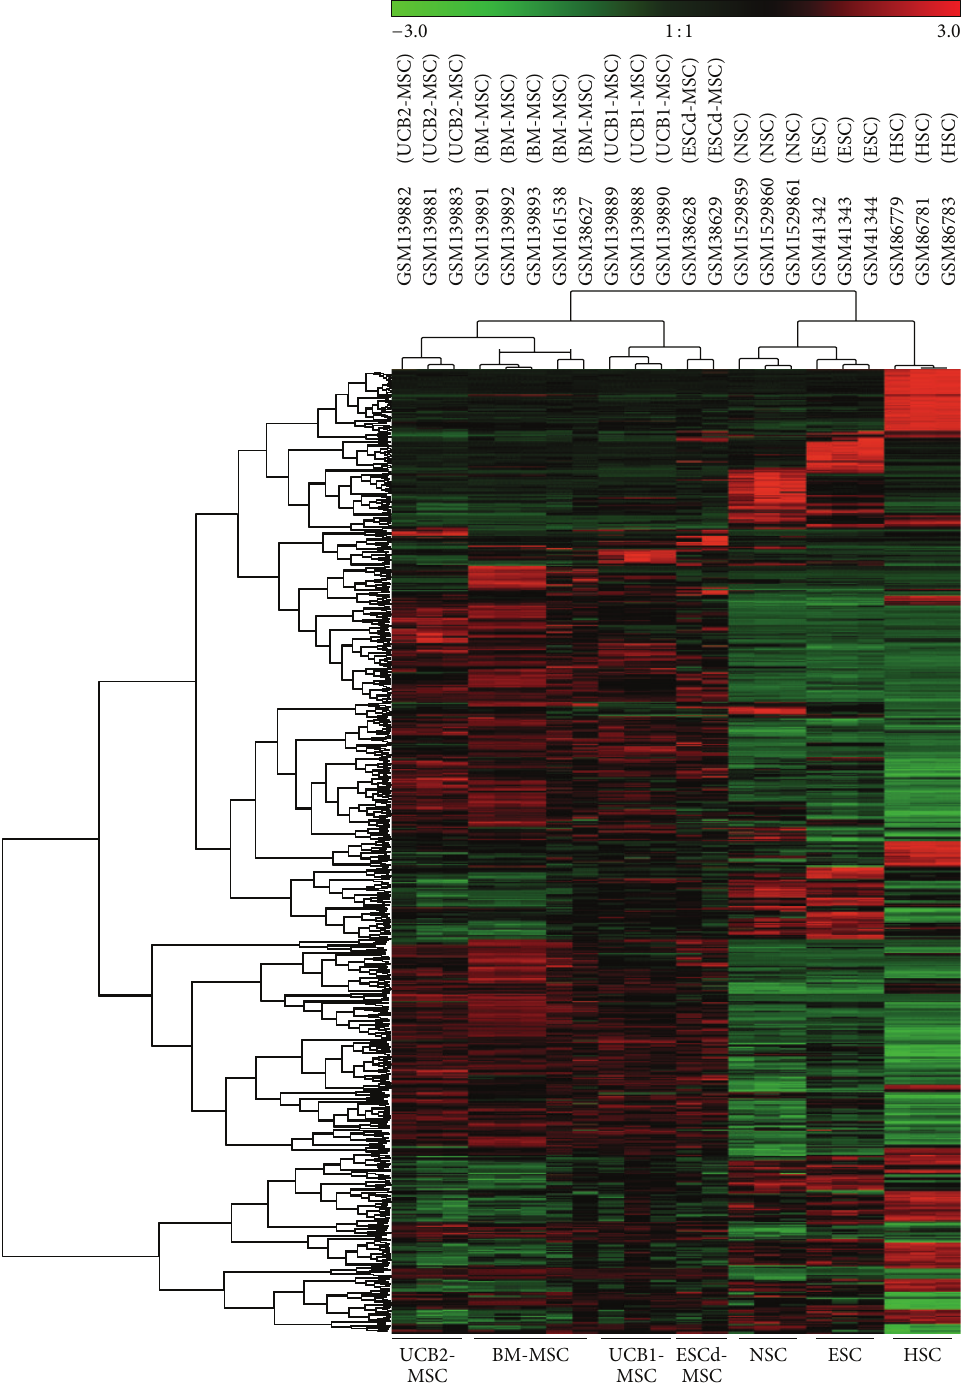
Figure 1: GEMusicA can discriminate between different stem cell types. DNA microarray cel files from embryonic stem cells (ESC) [16], neuronal stem cells (NSC) [21], hematopoietic stem cells (HSC) [19], bone marrow derived mesenchymal stem cells (BM-MSC) [3, 16, 18], two types of umbilical cord blood derived mesenchymal stem cells (UCB1-MSC, UCB2-MSC) [18], and mesenchymal stem cells derived from embryonic stem cells (ESCd-MSC) [16] were RMA-normalized and used for transformation into melodies using the GEMusicA implementation in R. The following parameters were used: minfreq = 27.5 , tonesteps = 12 , numkeys = 88 , mindur = 8 , vol = 4 , TeXscalefactor = 1 , maxNdots = 2 , and 𝑁 = 1114 . Presented is a cluster analysis of the GEMusicA-processed 1114 probe sets (Manhattan distance, complete linkage